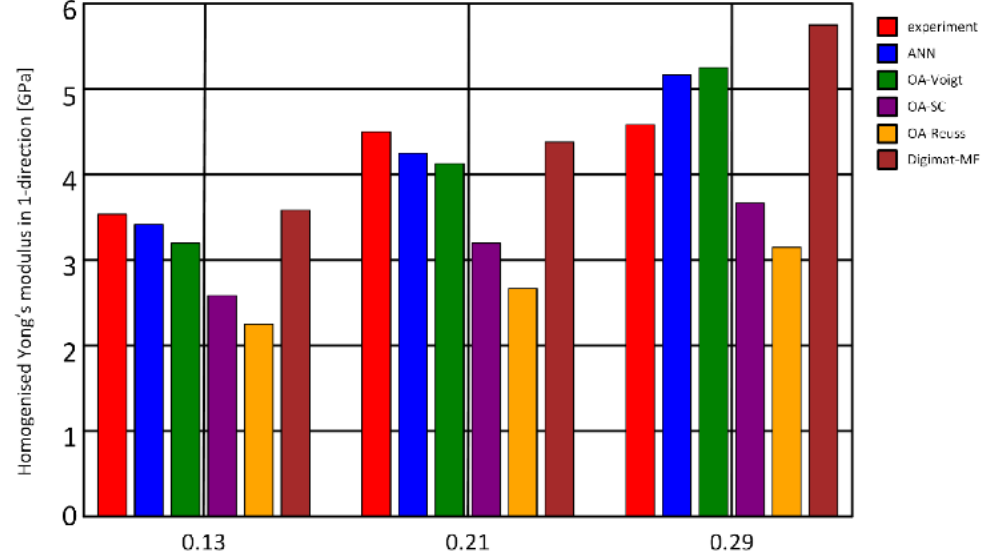
Figure 2. Machine learning for property prediction of materials. ANN—artificial neural networks. OA—orientation averaging. Digimat-MF—mean-field predictions. Reprinted from Ref. [20]. Copy- right 2021 The Authors. Published by Elsevier Ltd. This is an open access article under the CC BY license.